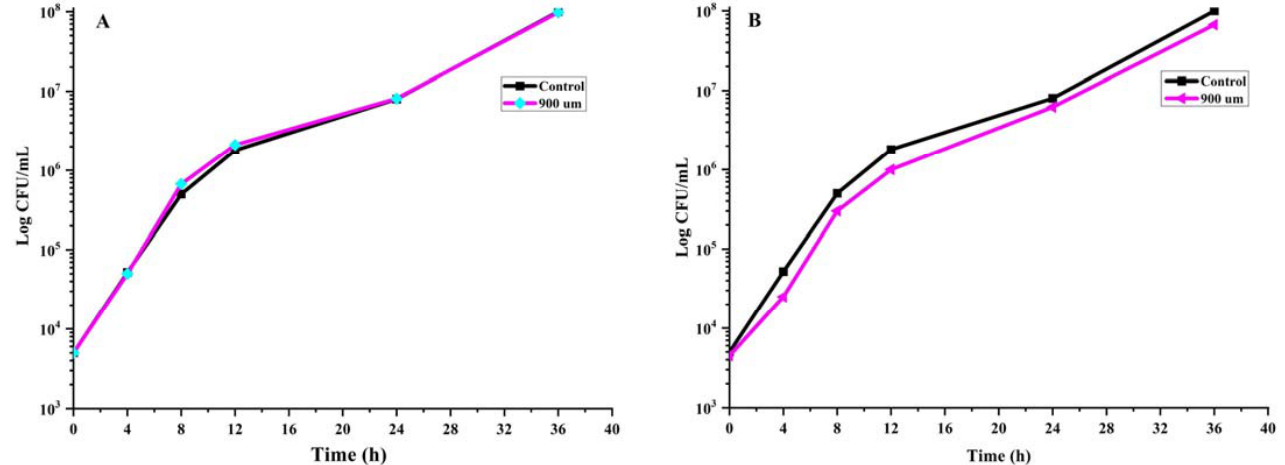
Figure 2. Time kill dynamics of B. breve and B. adolescentis upon treatment with 0, 300, 600 and 900 μ m EU nano ‐ emulsion. Only 0 and 900 μ m concentration effects on growth have been shown to avoid overlapping, as there was no reduction in the growth of B. breve ( A ) and B. adolescentis ( B ) at any